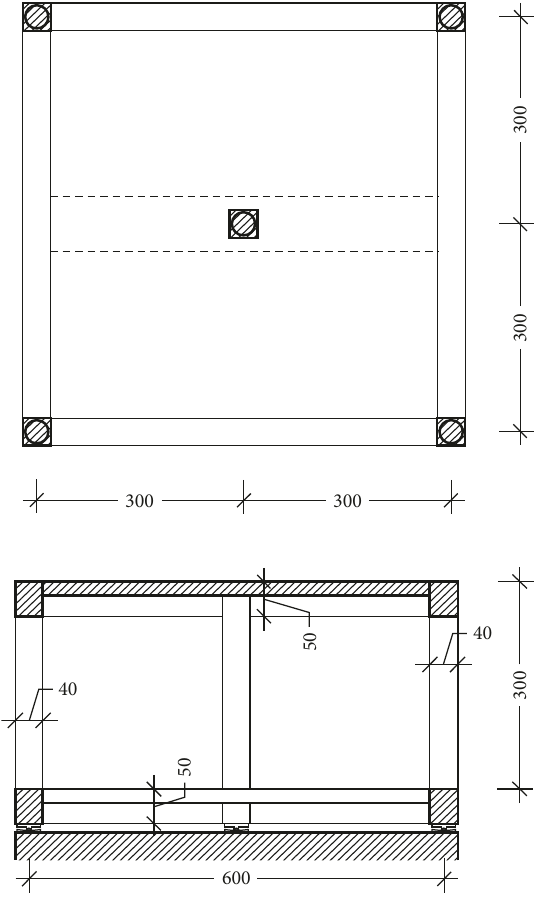
Figure 15: Five columns frame (dimensions in cm).